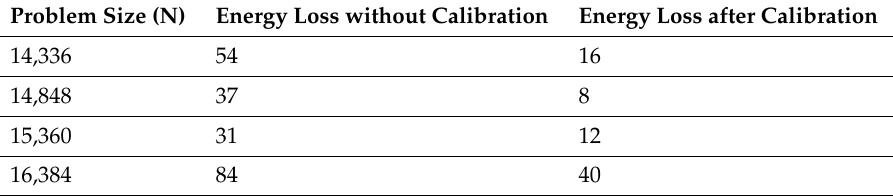
Table 10. Dynamic energy loss with RAPL in comparison with